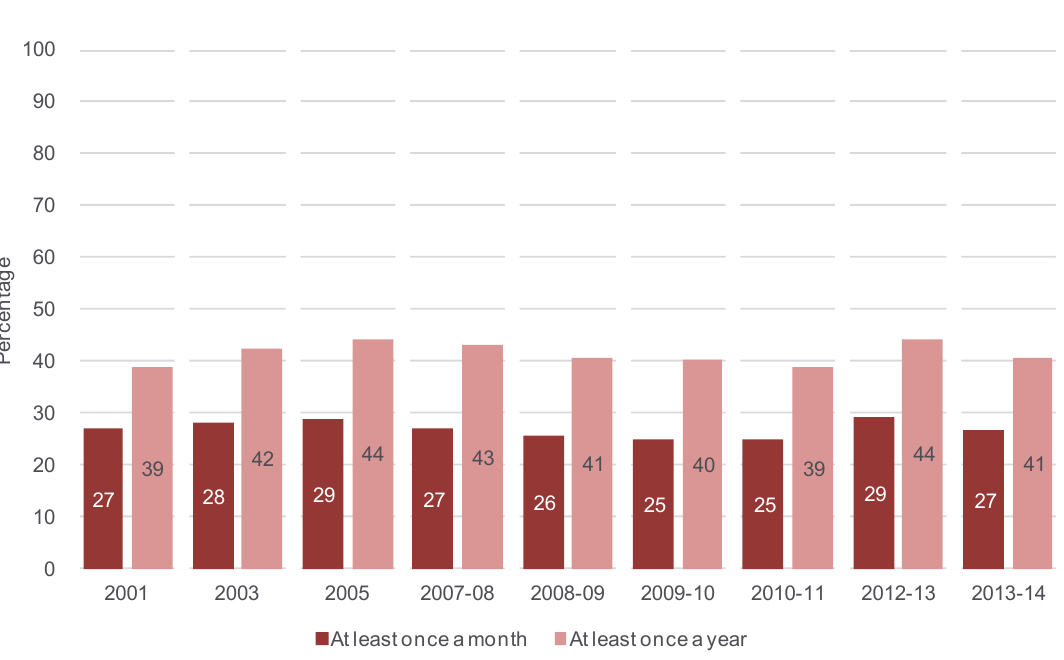
Figure 3: Whether people had participated in formal volunteering, 2001 to